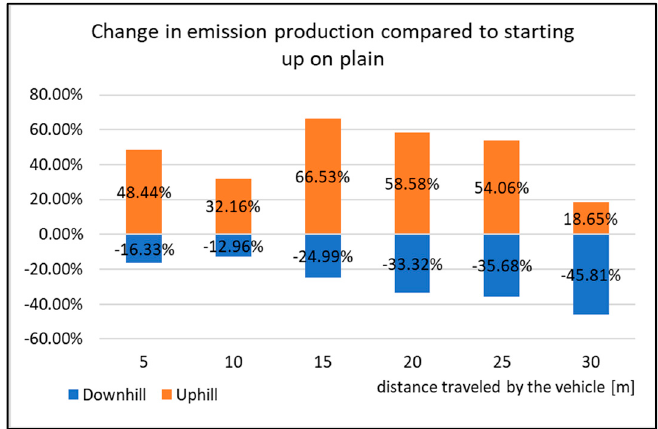
Figure 15. Change in emissions production compared to starting up on plain.